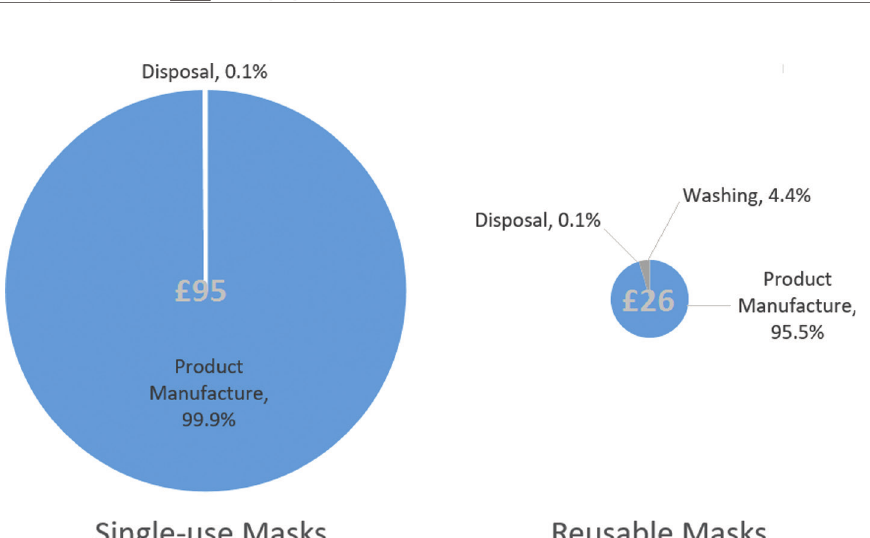
Total annual cost (£) for the supply of single-use and reusable face masks per UK citizen and the percentage